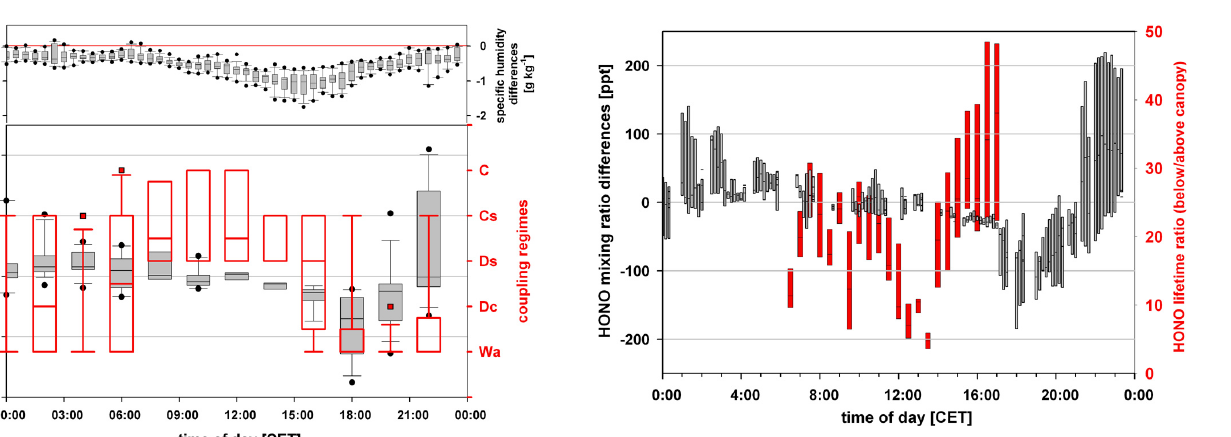
Fig. 5. Box-and-whisker plot for coupling regimes (red open bars) and HONO mixing ratio differences (grey filled bars) for the five-day dry period 20–25 September 2007 at the “Waldstein- Weidenbrunnen” research site. Wa (Wave motion ∼ no turbulent exchange), Dc (decoupled canopy ∼ whole canopy decoupled from the air layer above), Ds (decoupled subcanopy ∼ only subcanopy decoupled), Cs (coupled by sweeps ∼ canopy and subcanopy cou- pled by sweep motion) and C (fully coupled canopy). The up- per panel shows the specific humidity difference between 21m and the forest floor for comparison. The upper end of the boxes rep- resents the 75 th percentile, the lower end the 25th percentile and the line within the boxes the median. Whiskers denote the 10th (lower whisker) and 90th (upper whisker) percentiles. Outliers are marked as points (HONO difference) or squares (coupling regimes). If only whiskers appear, there are no other values between the val- ues marked by the whiskers. For the boxes at 10:00 and 14:00 the median falls in line with the lower end of the boxes (Ds).